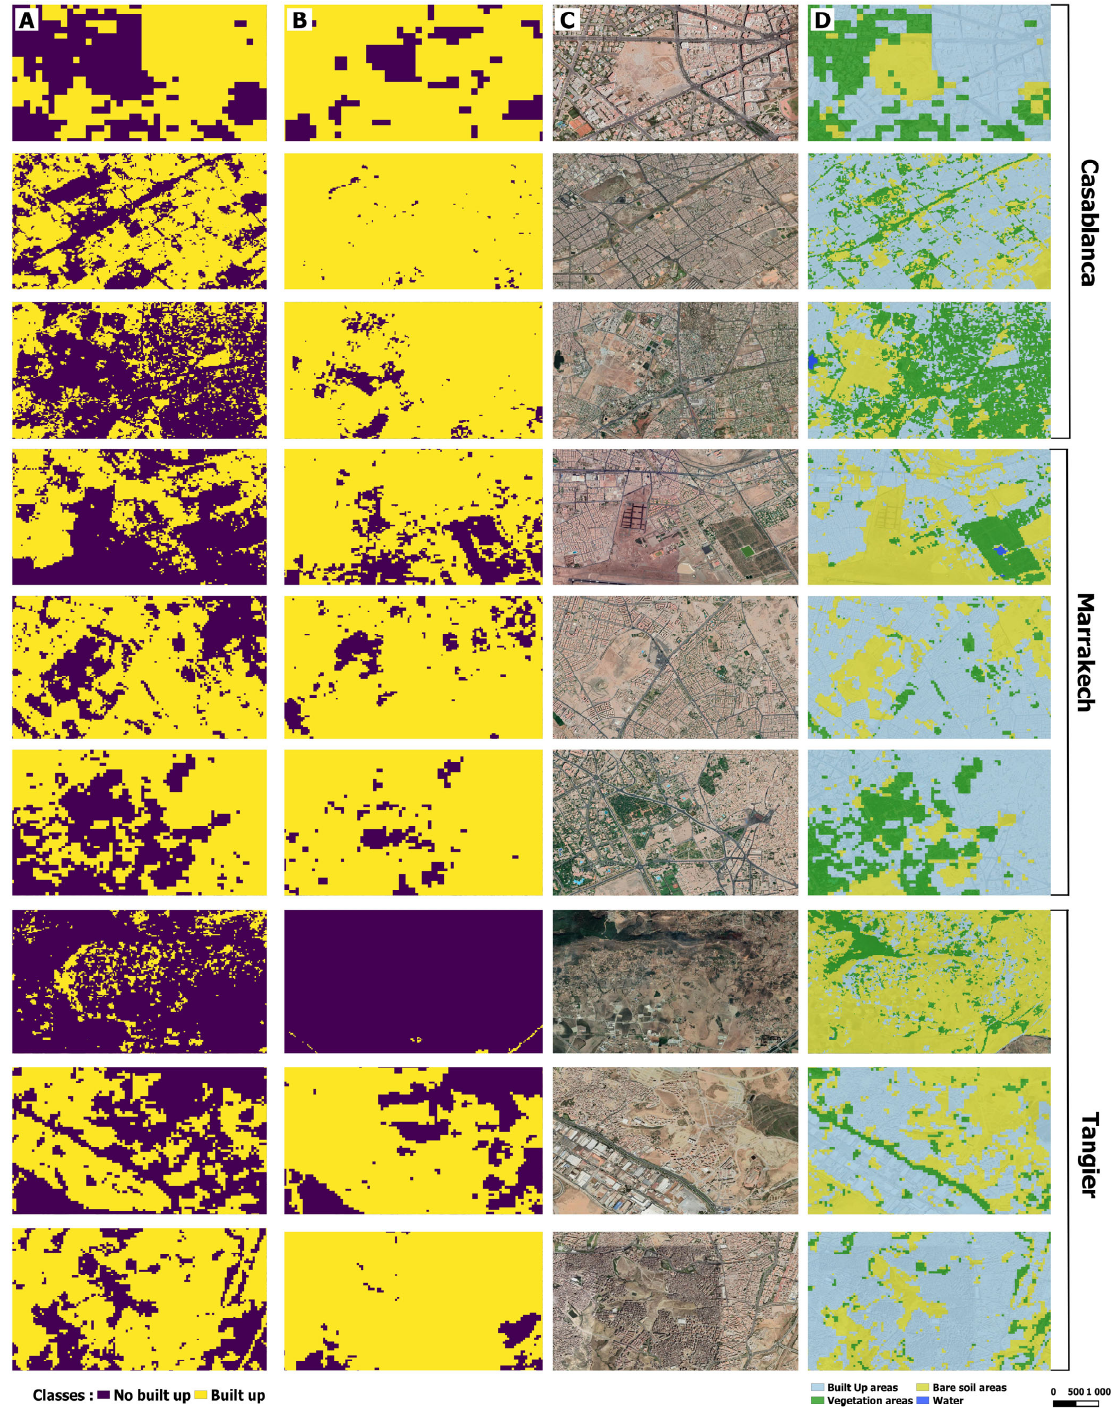
Figure 6. Visual comparison between ( A ) HLULC data, ( B ) GAIA, ( C ) high spatial resolution reference image, and ( D ) original classified image of HLULC.